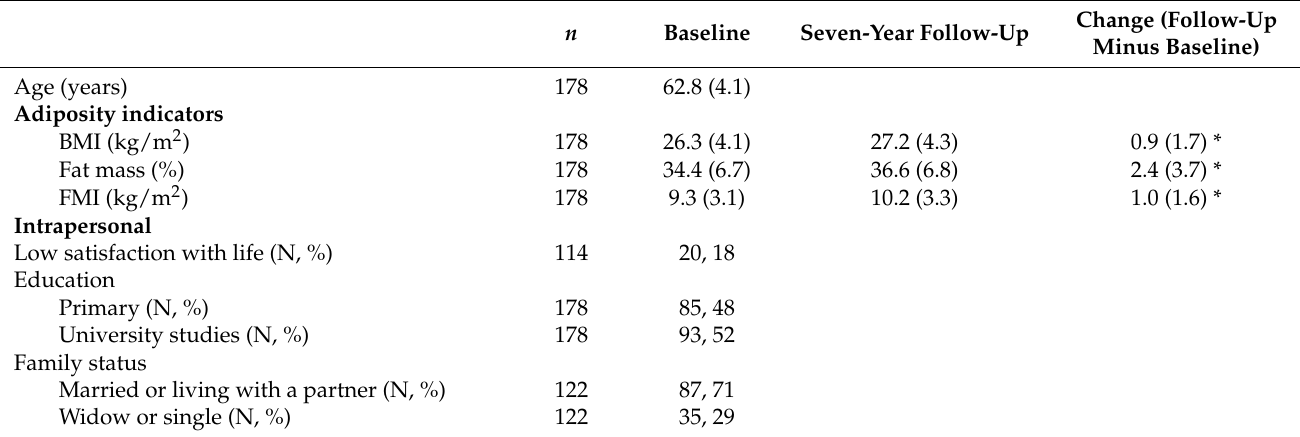
Table 1. Description of the baseline characteristics and adiposity changes of all the women participating in the prospective seven-year follow-up